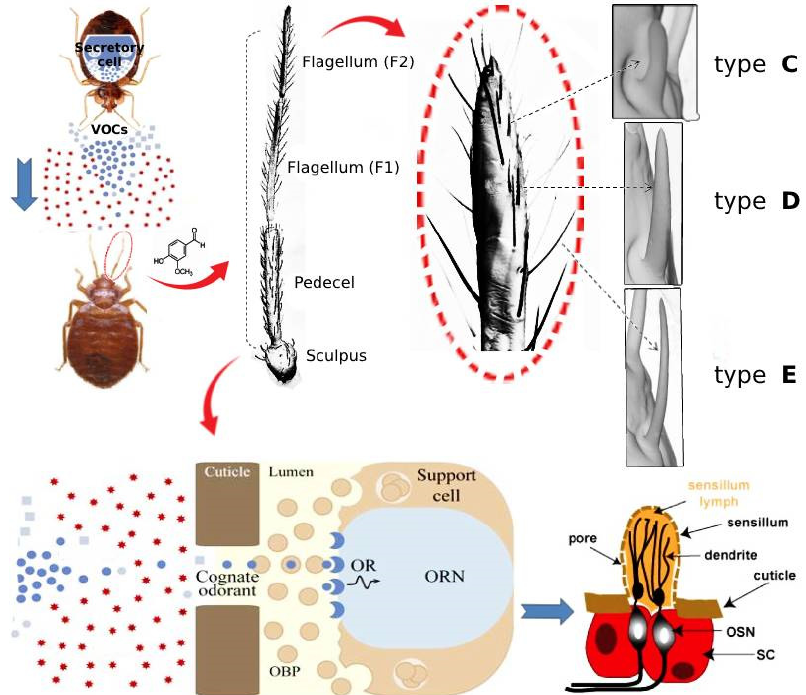
Figure 1. Schematic presentation of VOC perception in bed bugs.